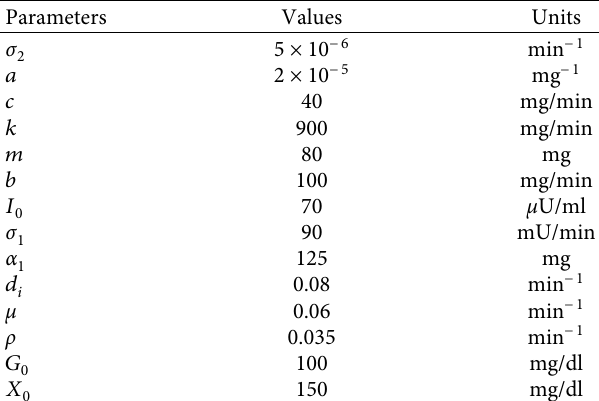
Table 1: Model parameter